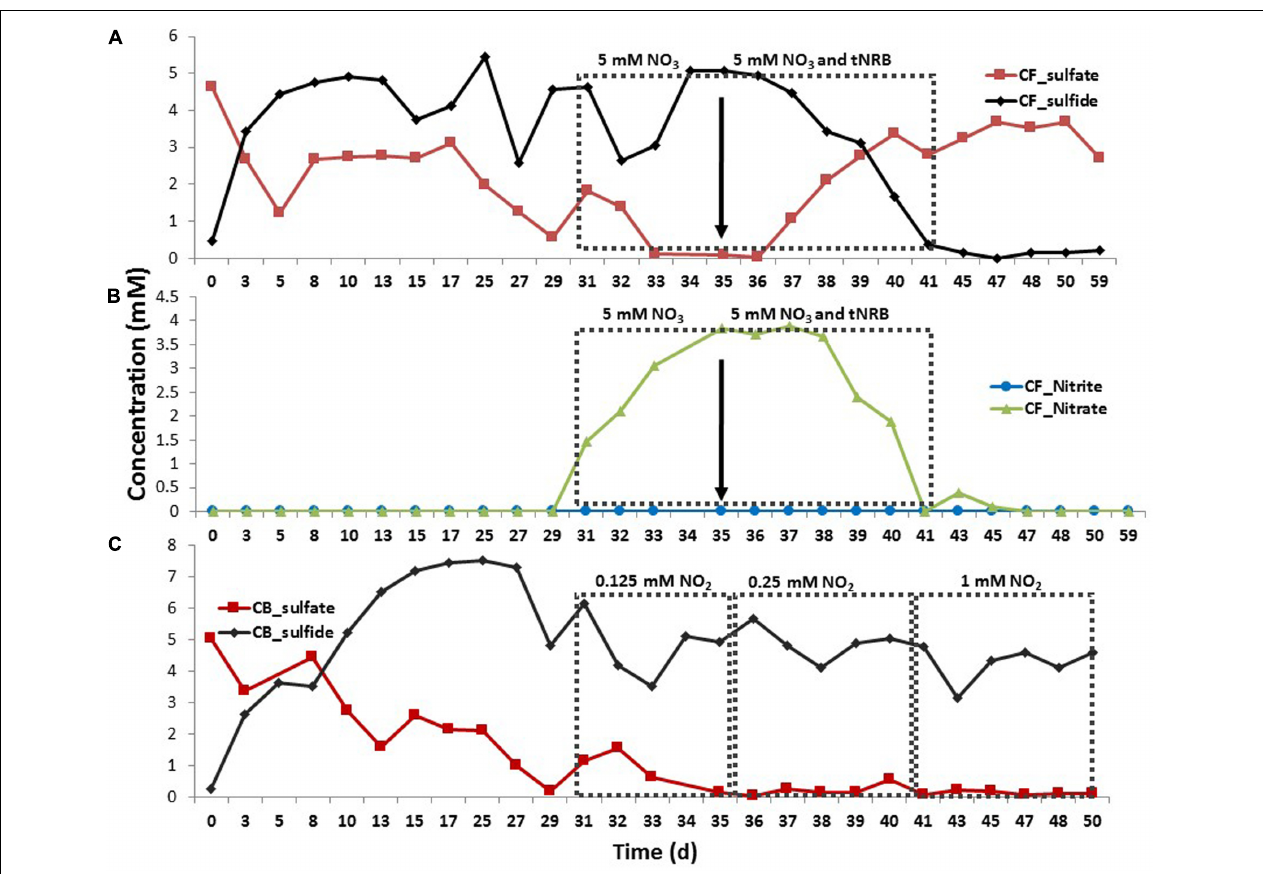
FIGURE 8 | Effect of addition of nitrate, of nitrate and tNRB, or of nitrite on tSRB activity during continuous culture conditions at 60 ◦ C. The concentrations (mM) are shown as a function of time (days) for (A) sulfate and sulfide in chemostat F (CF), (B) nitrate and nitrite in CF and (C) sulfate and sulfide in chemostat B (CB). CF was injected with medium containing lactate and sulfate. This was switched to medium with lactate, sulfate and nitrate as indicated; tNRB were added as indicated ( ↓ ). CB was injected with medium containing lactate and sulfate with addition of 0.125, 0.250, and 1.0 mM of nitrite as indicated. Note that the time scale is not